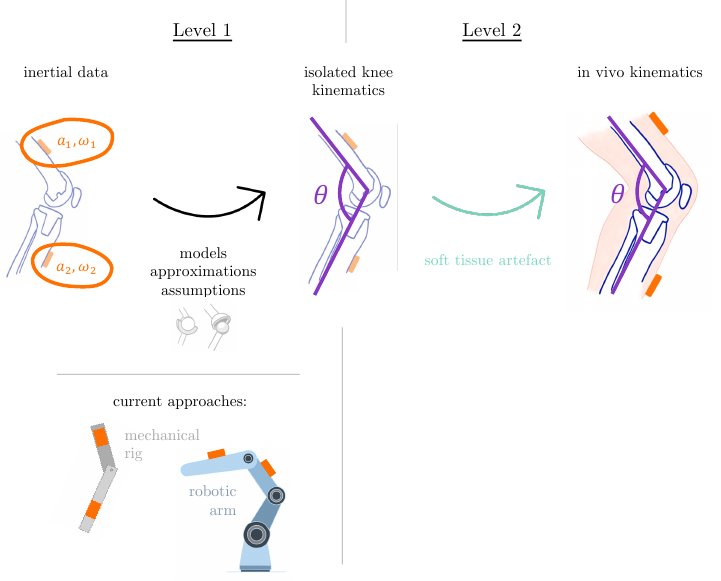
Figure 1. Analytical validation of an inertial-based tool for kinematic assessment should occur at different levels (e.g., with and without the possibility of soft-tissue artefact) to allow characterisation of different sources of